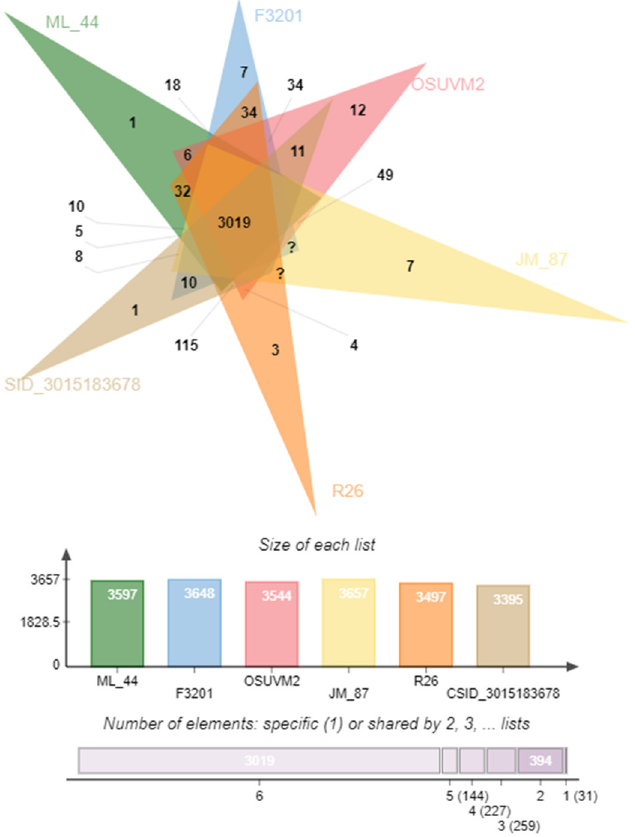
Figure 4. Results of ortholog genes analysis using OrthoVenn2. The Venn diagram shows the number of shared and unique orthologous genes clusters (gene families) among 6 E. anophelis strains.